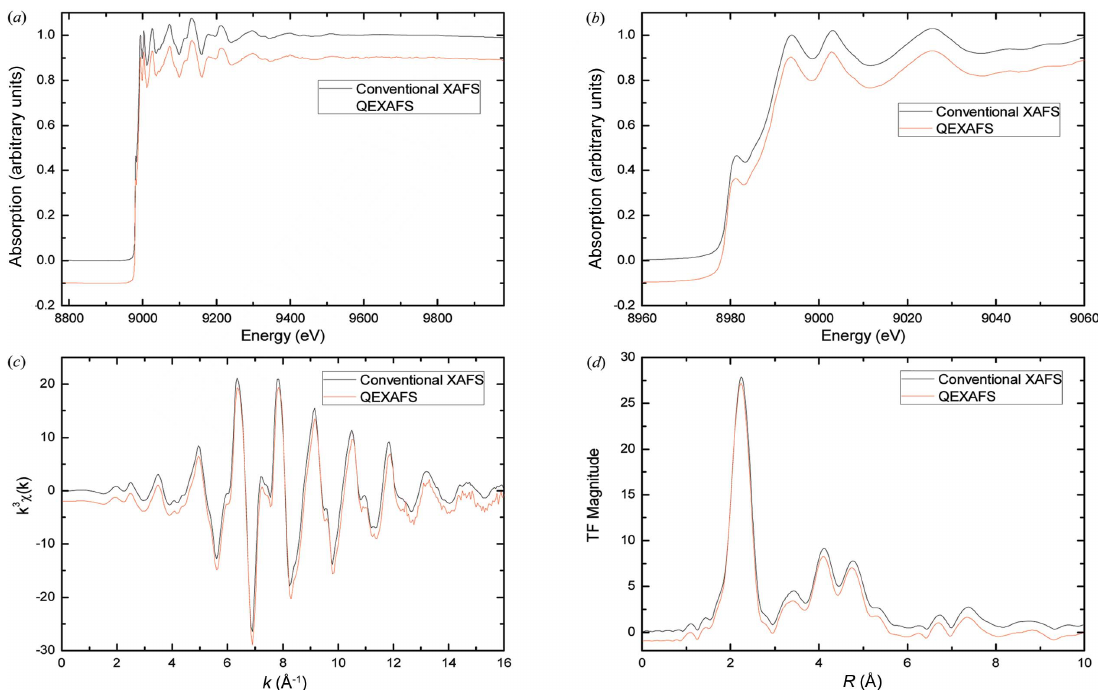
Figure 7 Comparison of the Cu K -edge XAFS spectra with a 1200 eV energy range measured with the QEXAFS system in less than 8 s and the conventional XAFS system in nearly 30 min. ( a ) Normalized XAFS spectra, ( b ) near-edge part, ( c ) k -space spectra, ( d ) R -space spectra.